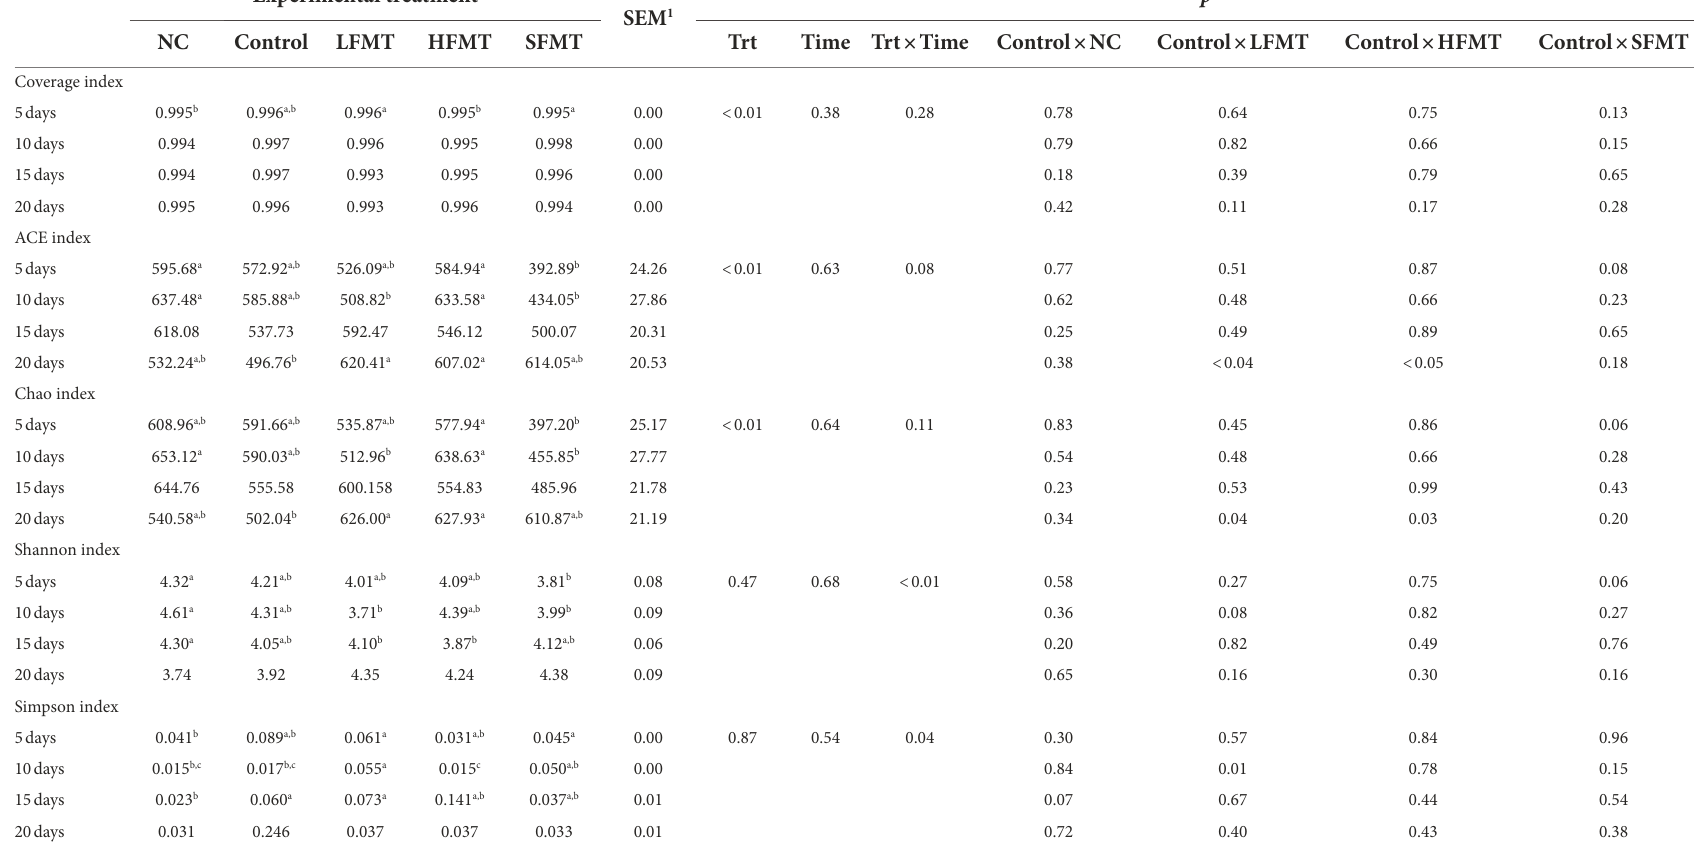
TABLE 2 Effects of different FMT treatments on the alpha diversity index of fecal bacteria in weaned Holstein calves. Experimental treatment SEM